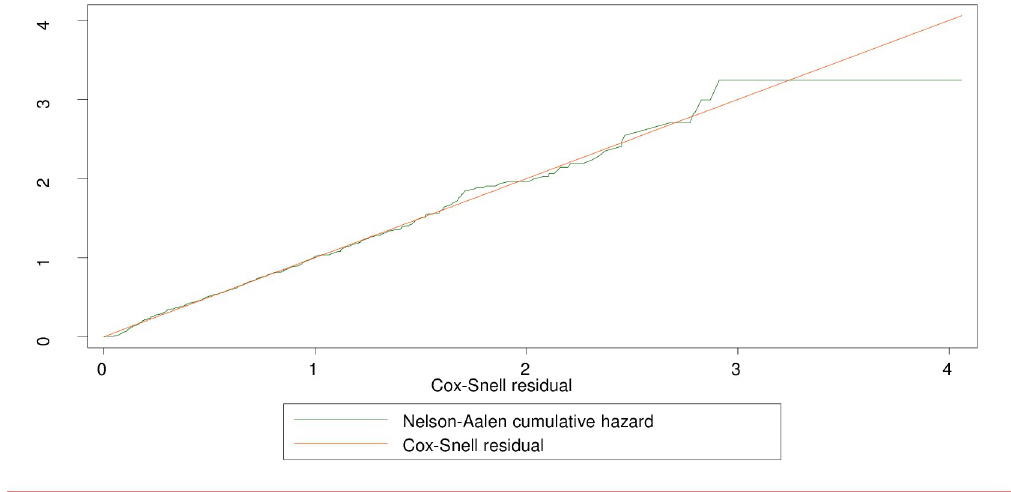
Fig 3. Cumulative hazard of Cox-Snell